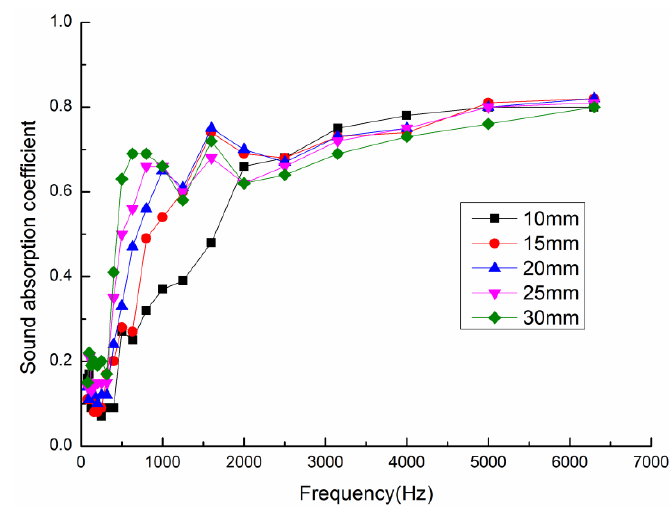
Figure 4. Sound absorption coefficient curves for composite materials with different thicknesses.